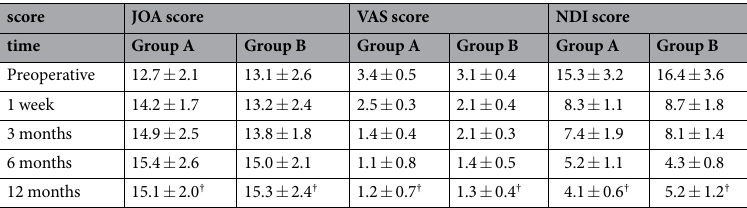
Table 3. Comparison of clinical outcomes of the two groups. JOA = Japanese Orthopaedic Association; NDI = neck disability index; VAS = visual analogue scale. † P < 0.05 compared to preoperative